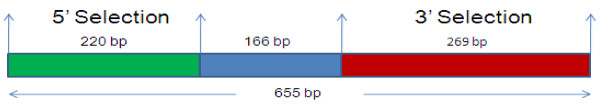
Schematic diagram of the 5' and 3' sections of the first EhSINE1 consensus sequence used to prepare the Hidden Markov Models.